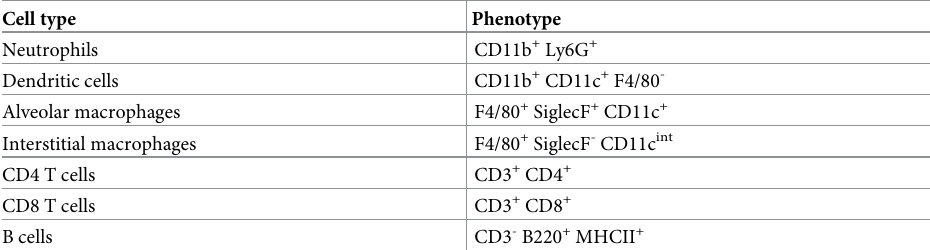
Table 1. Phenotypic determination of pulmonary immune